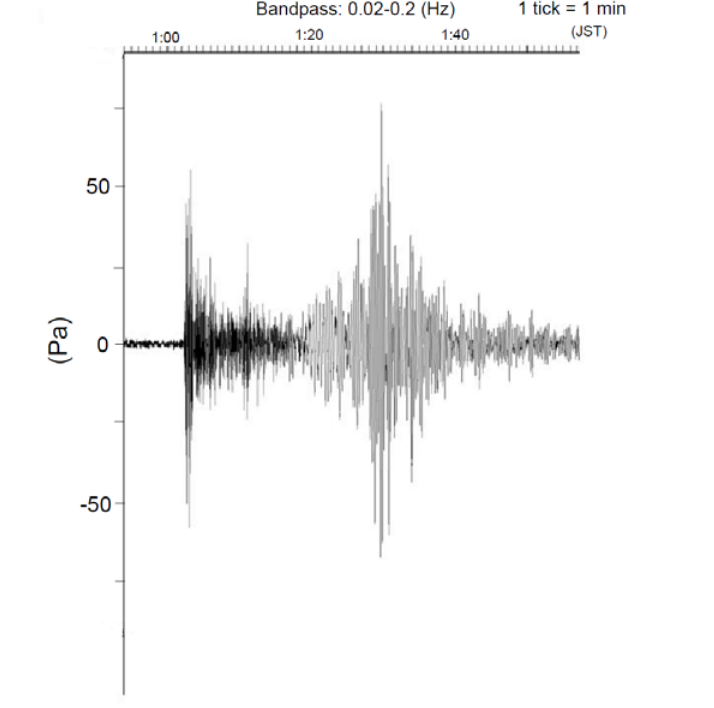
Figure 6. Clear surface waves as well as P and S phases from the Sumatra Island offshore earthquake on 29 March 2005, as sensed by this DPG at the seafloor